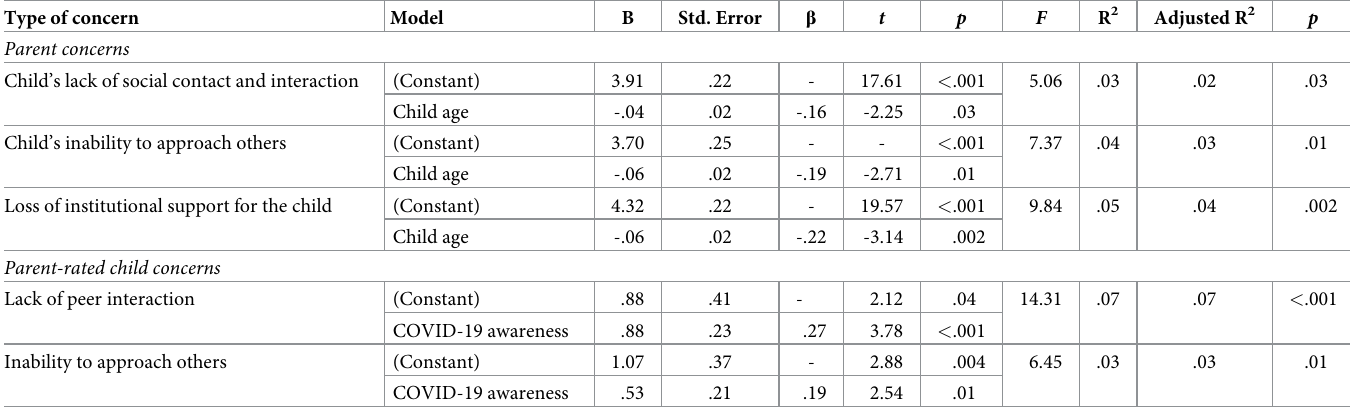
Parent concerns. Initial regression models included child age as a potential predictor of parent ratings of social concerns at time point 2 (at the beginning of COVID-19). The potential predictors that had a significant univariate association ( p < .05) with the parent concern rating were entered into the model with a stepwise approach. In the final models, child age was a unique predictor of parent ratings of concerns about the child’s lack of social contact, adjusted R 2 = .02, F (1, 190) = 3.78, p = .03, inability to approach others, adjusted R 2 = .03, F (1, 190) = 7.37, p = .01, and the loss of institutional support for the child, adjusted R 2 = .04, F (1, 191) = 9.84, p = .002 (Table 4). Parent concern ratings of the child’s lack of social contact, inability to approach others, and the loss of institutional support for the child were greater for parents with younger children ( β = -.04, t (190) = -2.25, p = .03; β = -.06, t (190) = -2.71, p = .01; β = -.06, t (191) = -3.14, p = .002, respectively). No unique predictor was attained for the parent concern rating of family conflict. Parent perception of child concerns. Initial regression models included child’s age and COVID-19 awareness as potential predictors of the parent ratings of child concerns. In the final models, the child COVID-19 awareness was a unique predictor of parent-rated child con- cerns about their lack of peer interaction, adjusted R 2 = .07, F (1, 180) = 14.31, p < .001, and Table 4. Final regression models: Child age predicting parent concern ratings and child COVID-19 awareness predicting parent ratings of child concerns. Type of